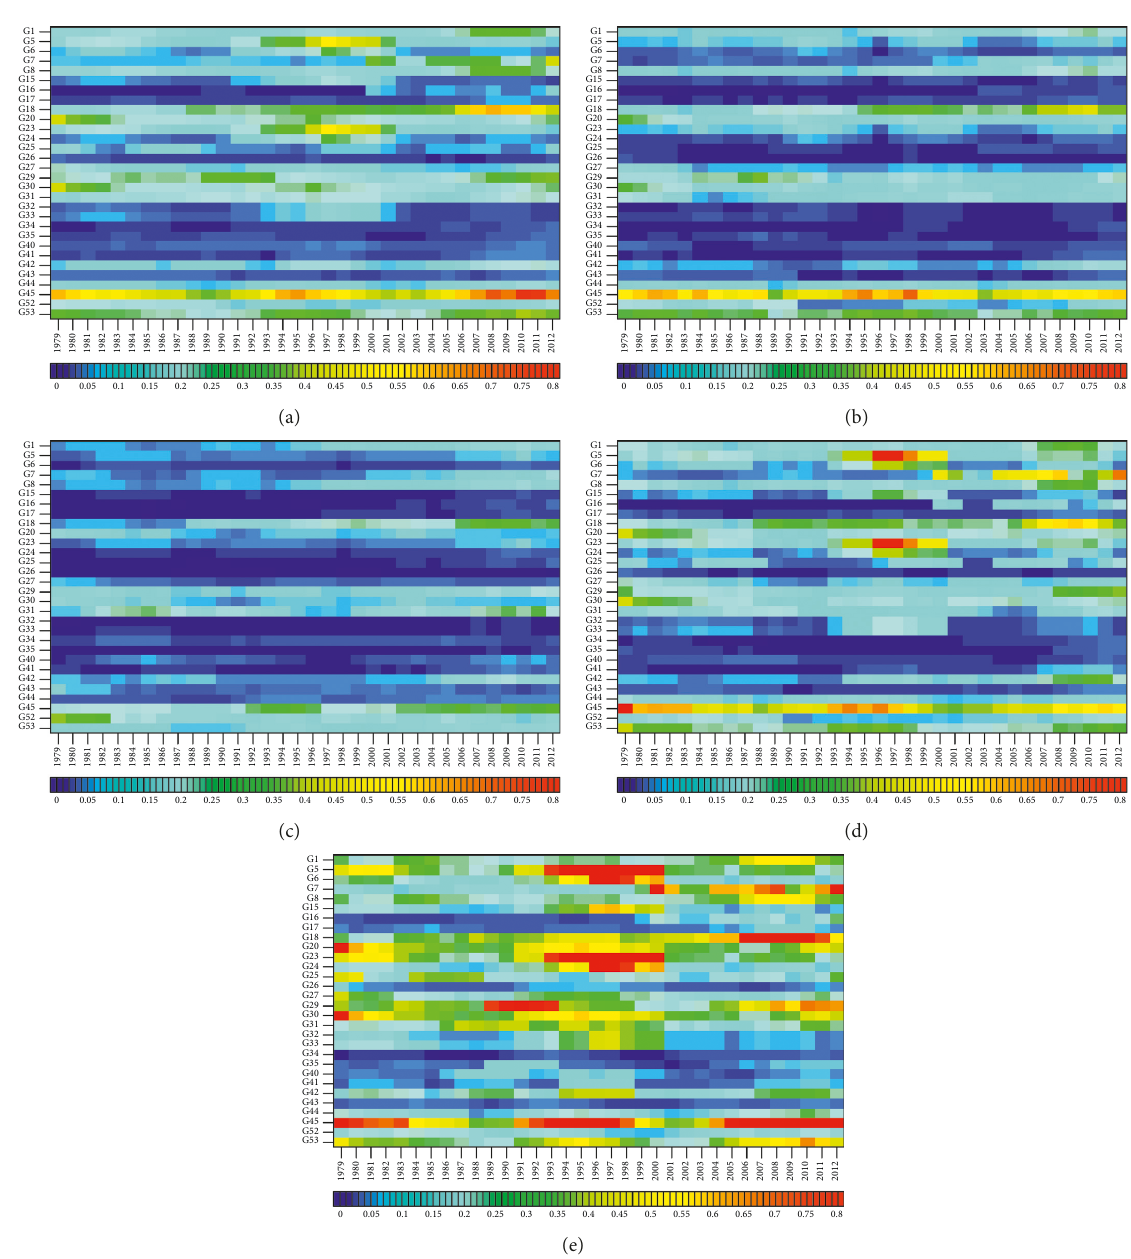
Figure 3: Annual variations of (a) annual and (b–e) seasonal mean sampling error variances ( ° C 2 ) in the TP from 1979 to 2012: (a) annual; (b) spring; (c) summer; (d) autumn; (e)